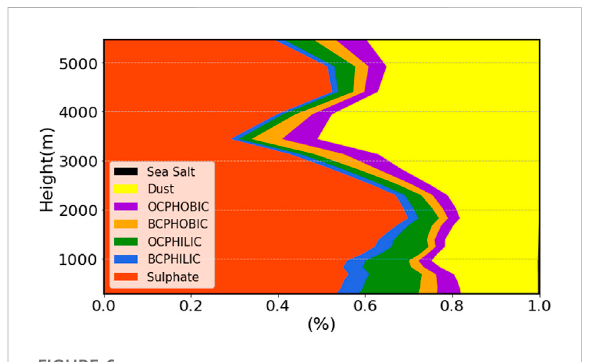
FIGURE 6 Relative fractions of aerosol composition types as a function of altitude (PHOBIC: hydrophobic, PHILIC: hydrophilic).